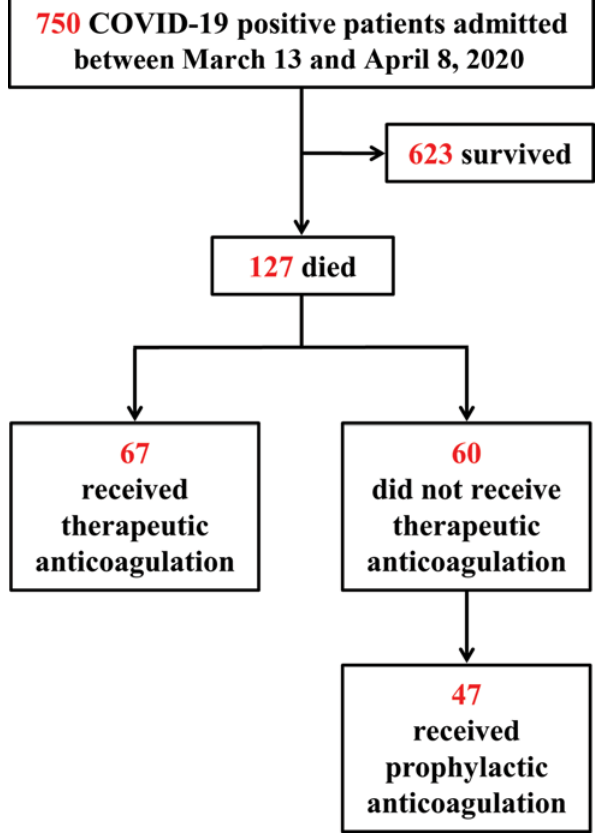
► Table 2 . The fi nal model found that AC was an independent